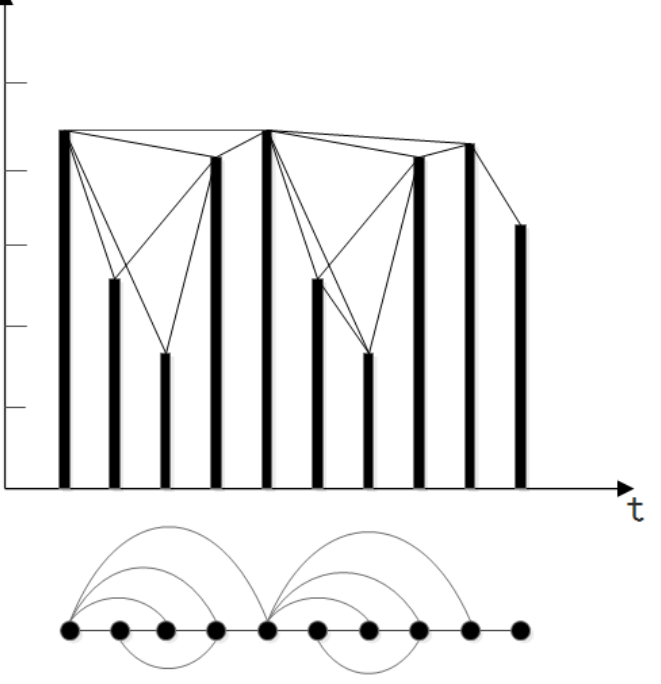
Figure 2. A VG construction example for time series